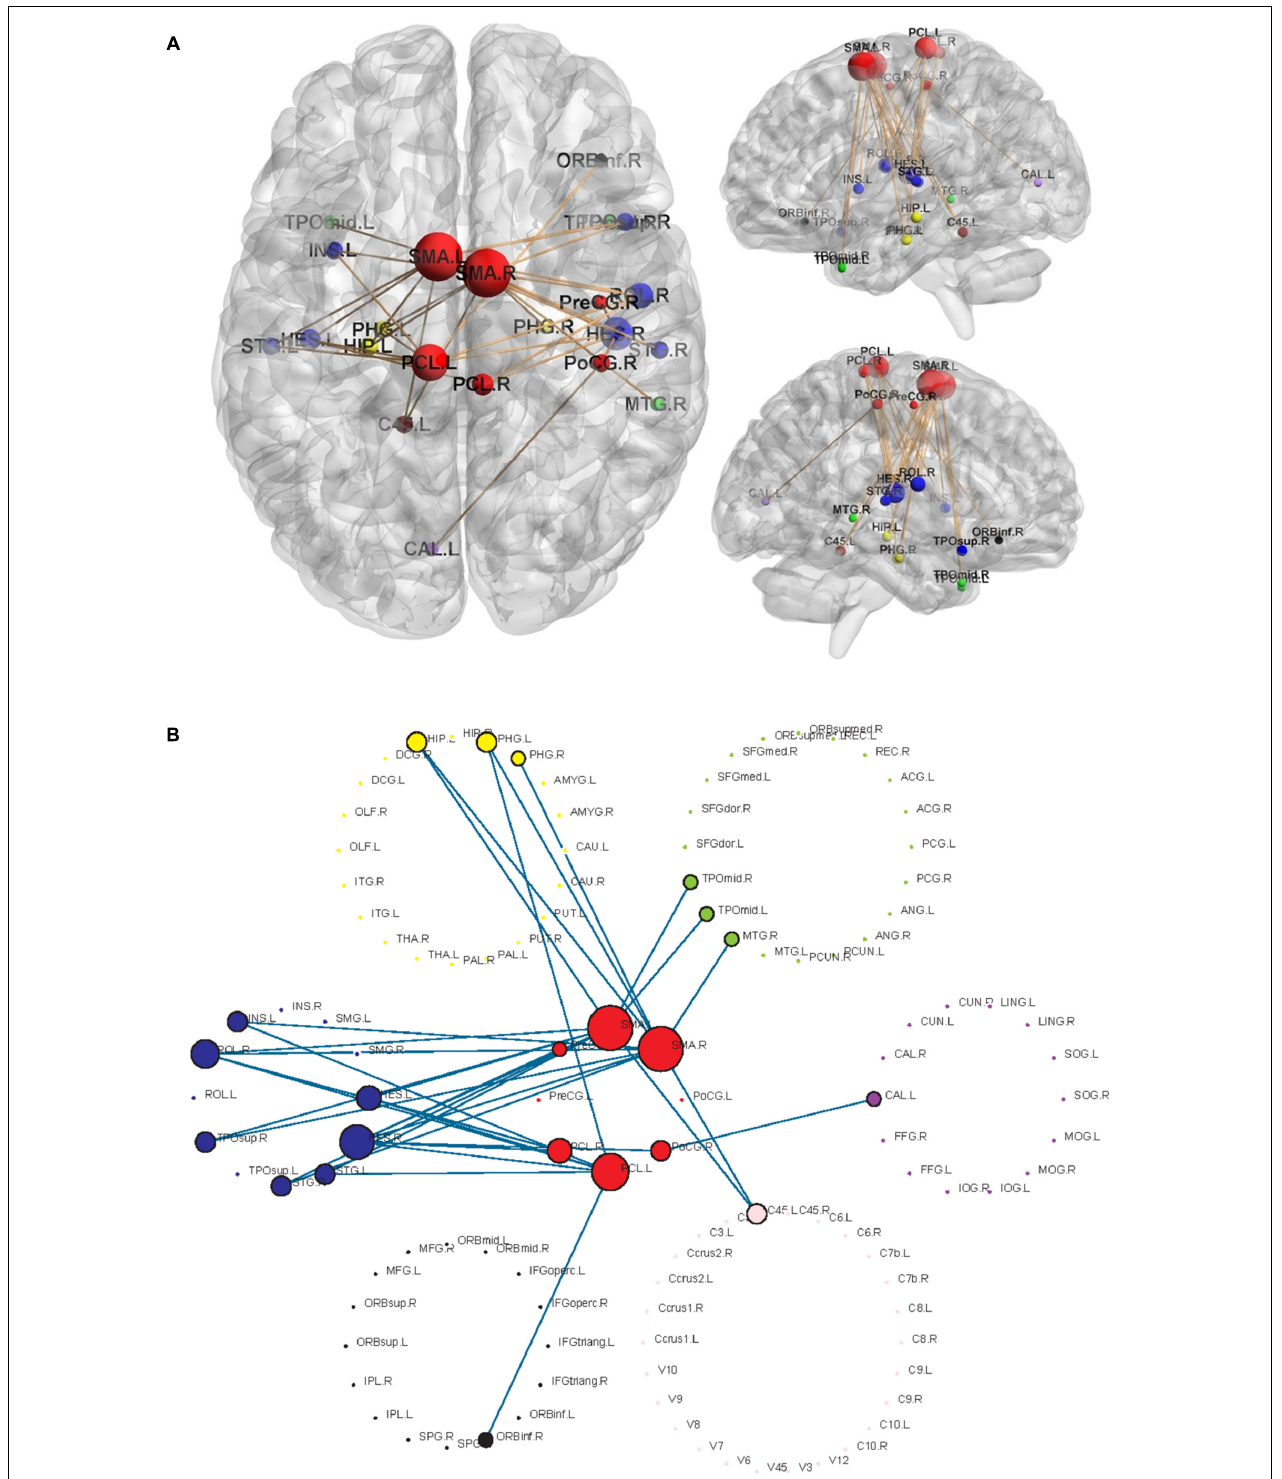
FIGURE 1 | Significant networks characterizing T2D using NBS analysis. The radius of the nodes is proportional to the number of connectivities related to the nodes. Different colors represent different networks, red = sensory-motor network; blue = auditory network; yellow = subcortical network; black = attention network; green = default mode network; purple = visual network; pink = cerebellum. (A) The changed functional connectivities in T2D patients and the locations of the nodes involved in the brain. (B) Highlighted structures of 7 RSNs and changed connectivities.